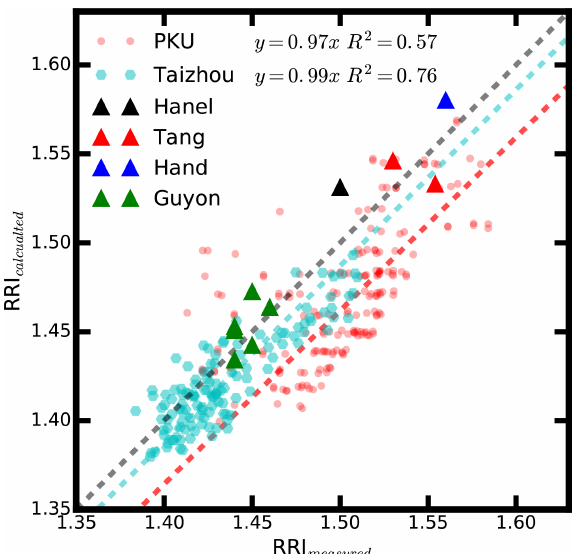
Figure 10. Comparison between the measured and calculated RRI for the PKU (red circles) and Taizhou (cyan hexagons) station. The triangles in black, red, blue and green correspond to the data from Hänel (1968), Tang (1996), Hand and Kreidenweis (2002), and Guyon et al. (2003), respectively. The black dashed line is the 1 : 1 line.